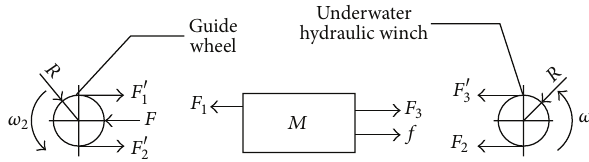
Figure 6: The force analysis of the closed flexible traction